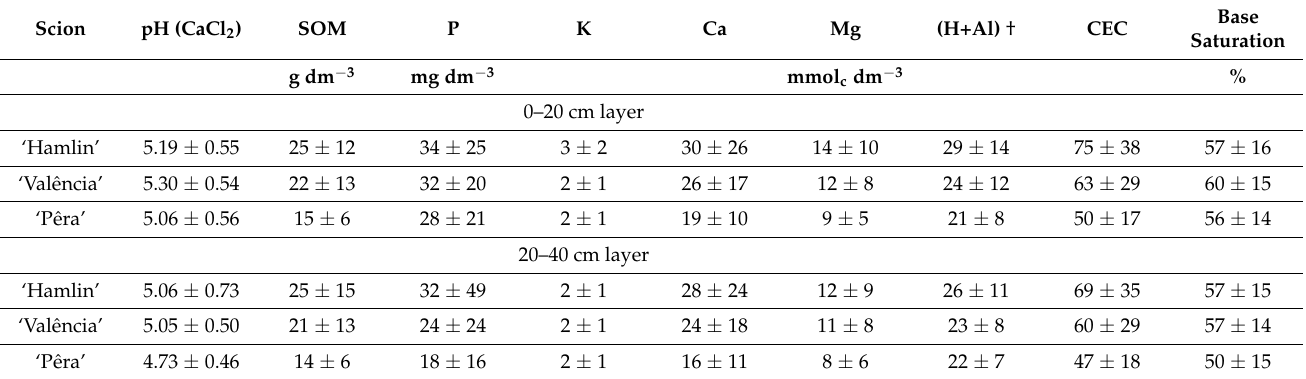
Table 3. Statistics of soil properties in the 0–20 and 20–40 cm layers.